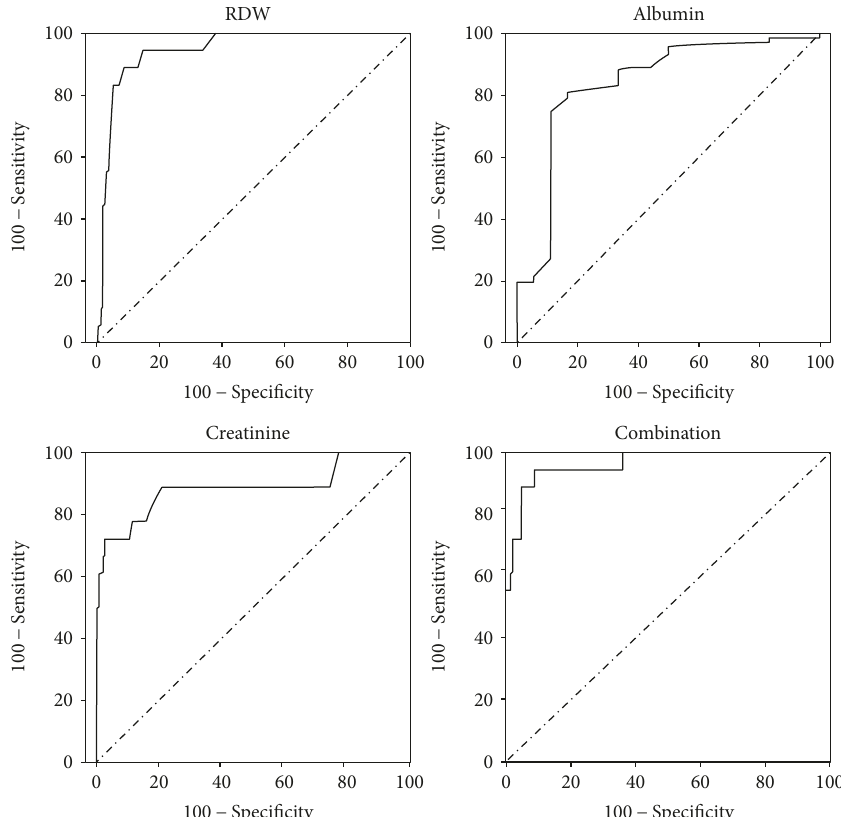
Figure 1: ROC curves for red cell distribution (RDW), creatinine, albumin, and the combination of the three indicators (combination). Table 2: ROC analysis for biochemical parameters of patients with acute pancreatitis.